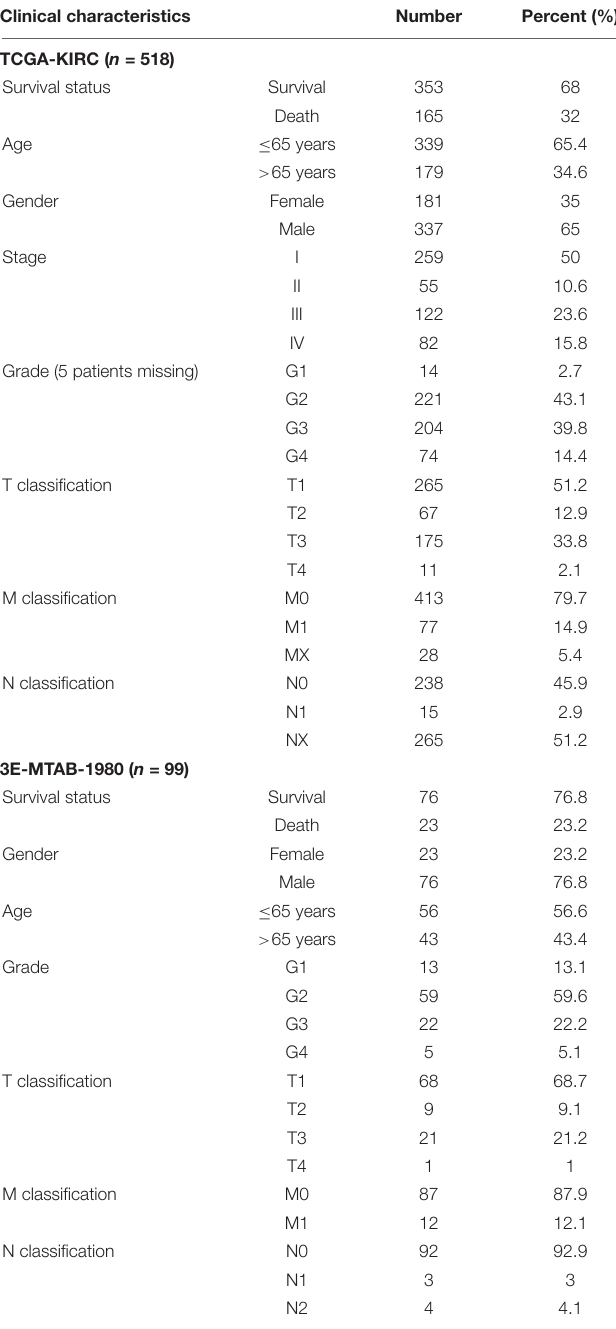
TABLE 1 | Baseline patient characteristic in the two cohorts. Clinical